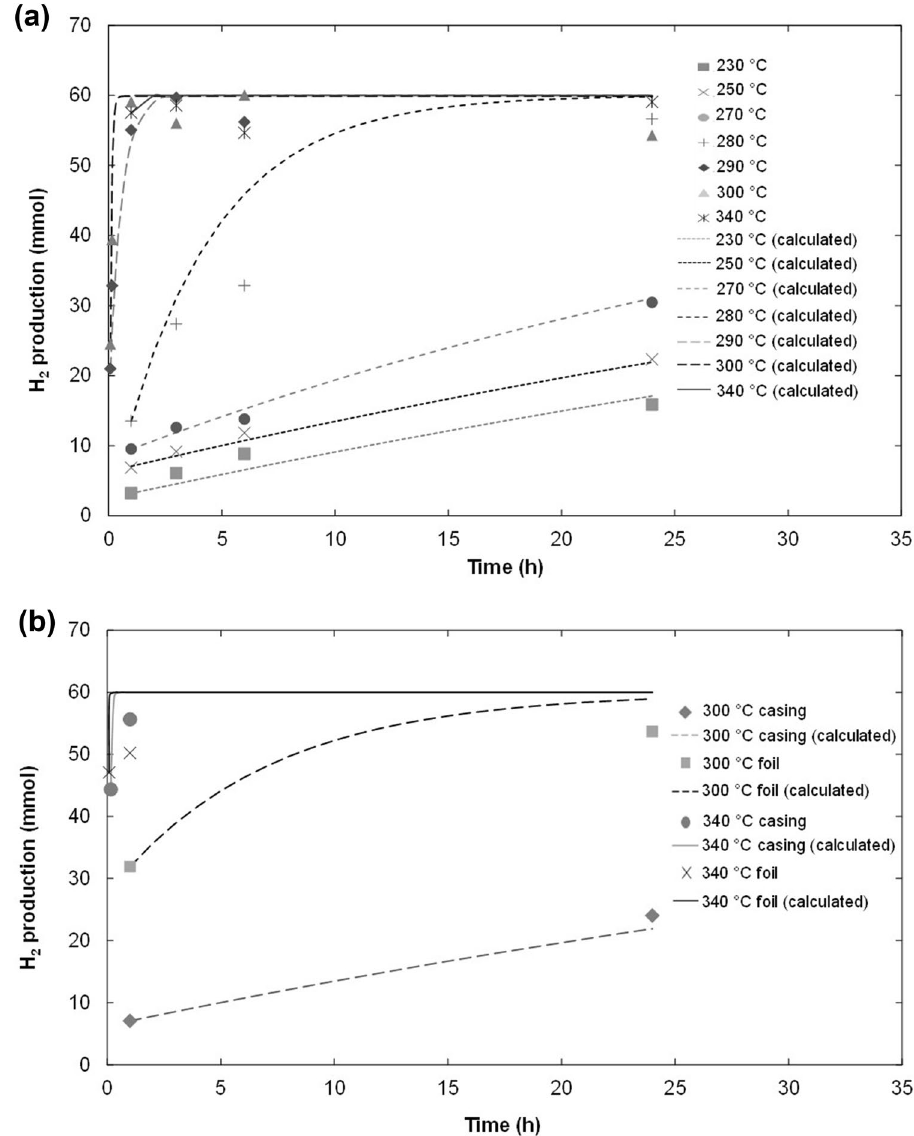
Fig. 11 Comparison of experi- mental and calculated values for hydrogen production from reac- tions using a aluminum powder, and b aluminum casing and